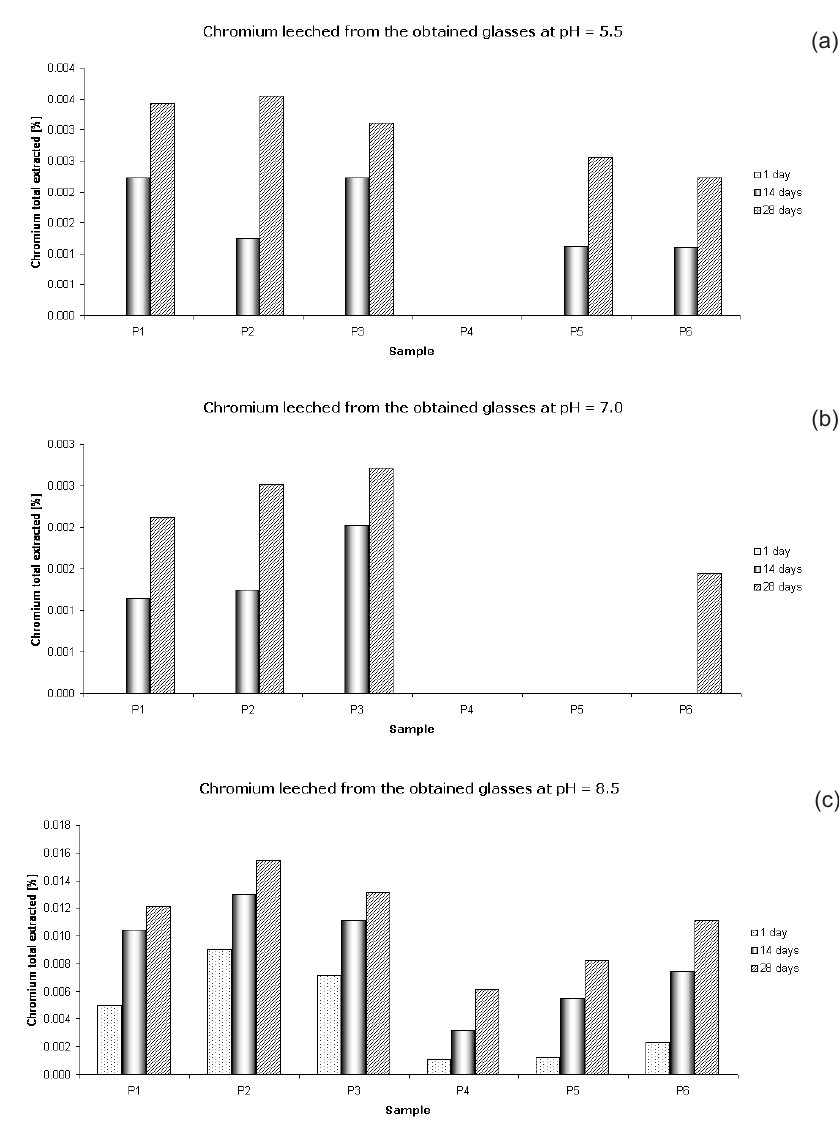
Figure 3. Total chromium ions leached from the